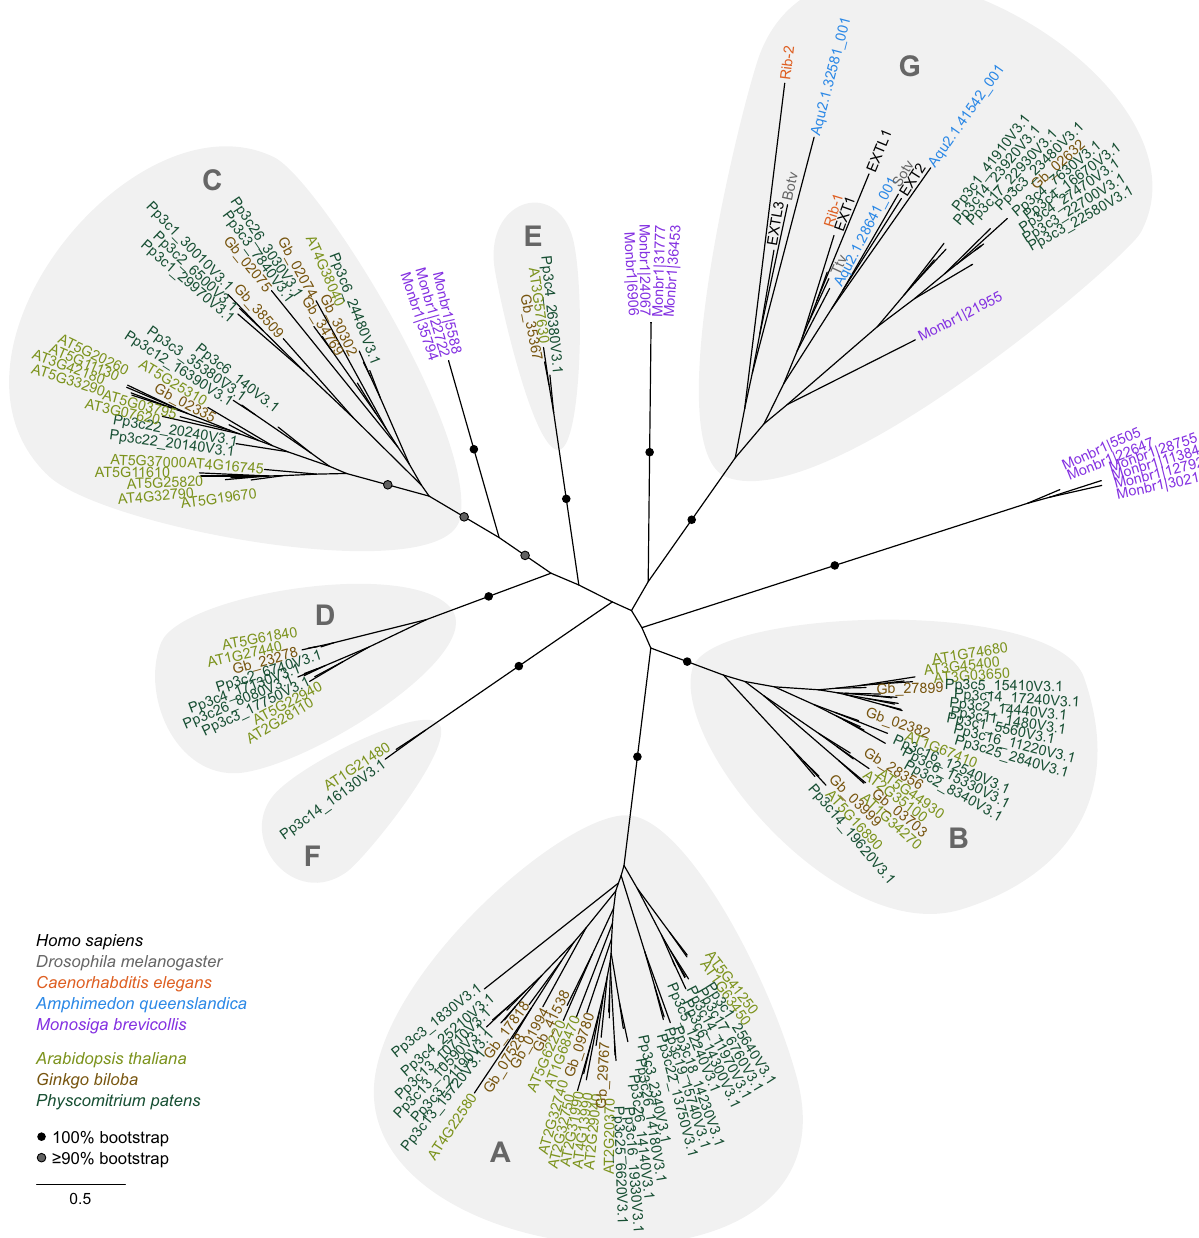
Fig. 7 Phylogenies of GT47 domain sequences from plant, animal, and choano fl agellate proteomes indicate the existence of a seventh GT47 clade containing sequences from both plants and opisthokonts. A phylogeny of GT47-domain sequences from Homo sapiens , Drosophila melanogaster , Caenorhabditis elegans , Amphimedon queenslandica , Monosiga brevicollis , Arabidopsis thaliana , Ginkgo biloba , and Physcomitrium patens was constructed using RAxML with 100 rapid bootstraps. Clades are labelled A – F according to reference 55 ; clade G is proposed in this work. For ease of viewing, bootstraps are displayed only for major splits: black circles represent splits present in all 100 bootstrap replicates, while grey circles indicate splits present in at least